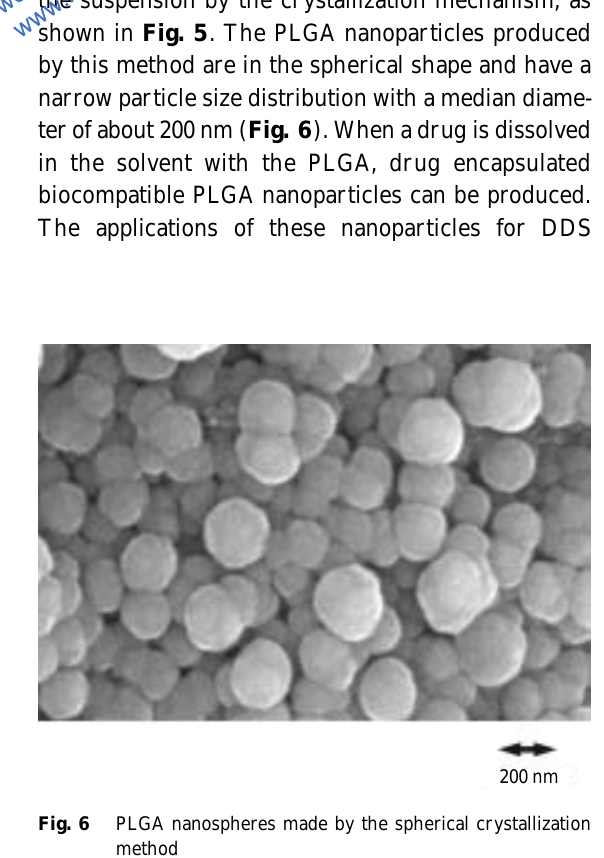
Fig. 6 PLGA nanospheres made by the spherical crystallization method